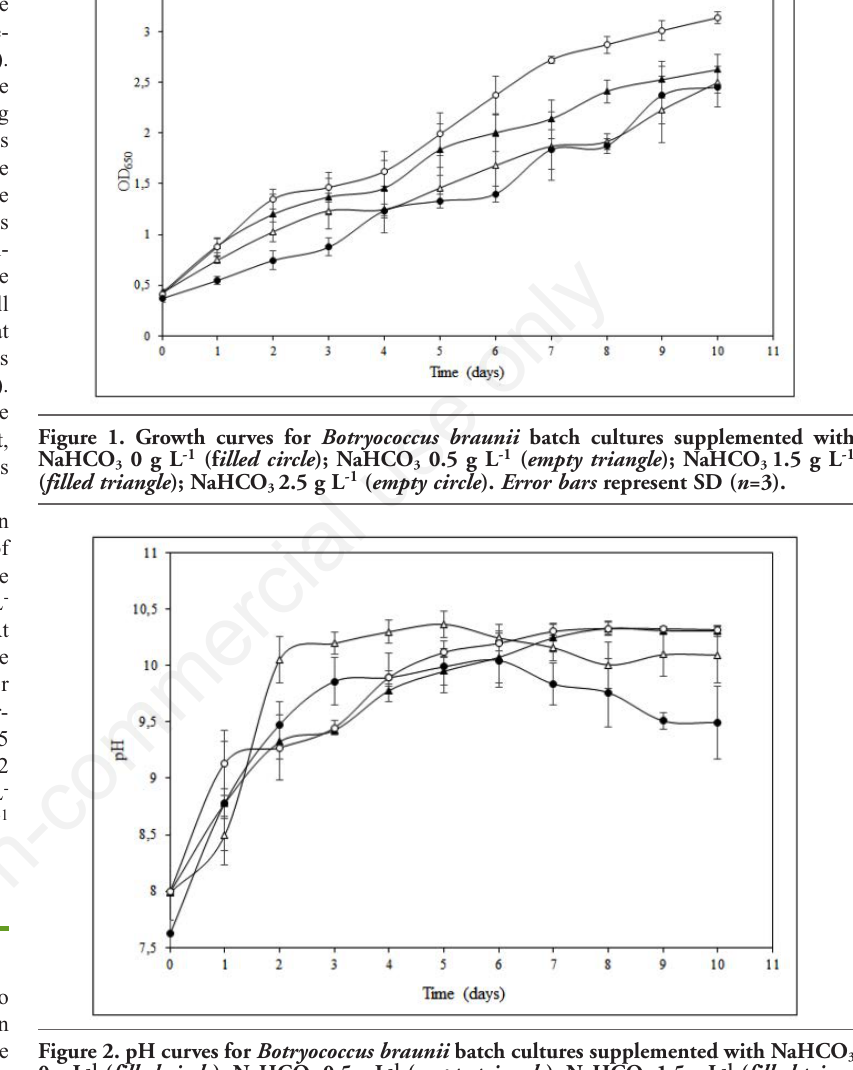
3 1.5 g L -1 ( filled trian- 3